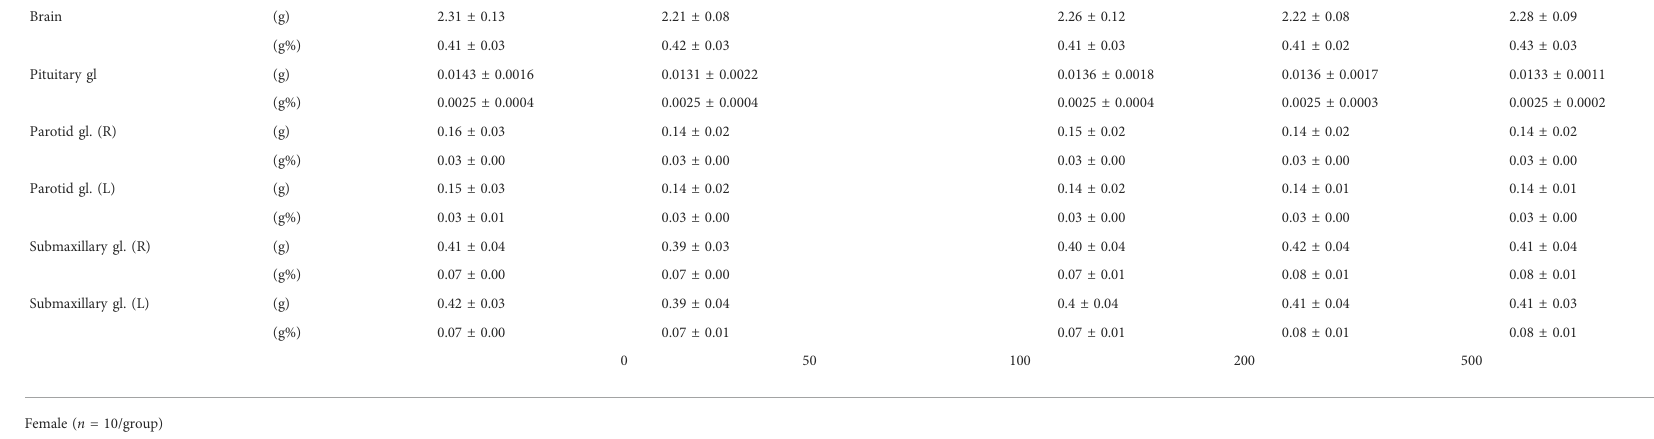
TABLE 3 ( Continued ) Absolute and relative weight of major organs from SD rats orally treated with lac dye for 90 days.